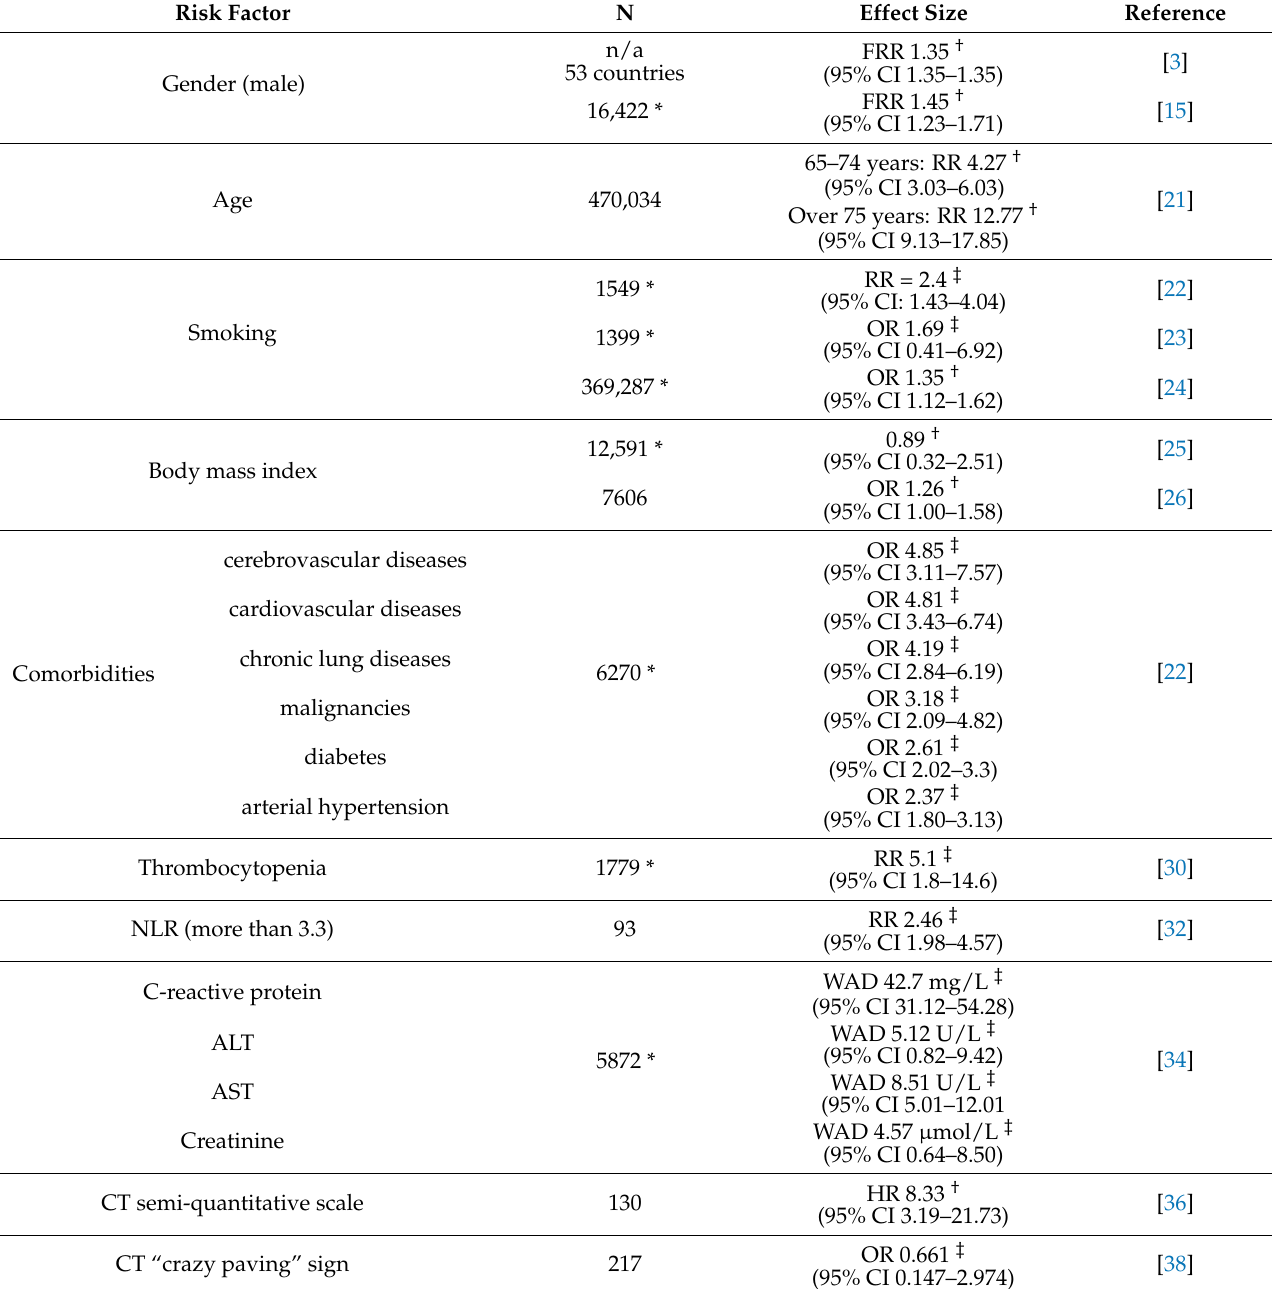
Table 1. Summary of the main risk factors of COVID-19 severe outcome or death reported in the